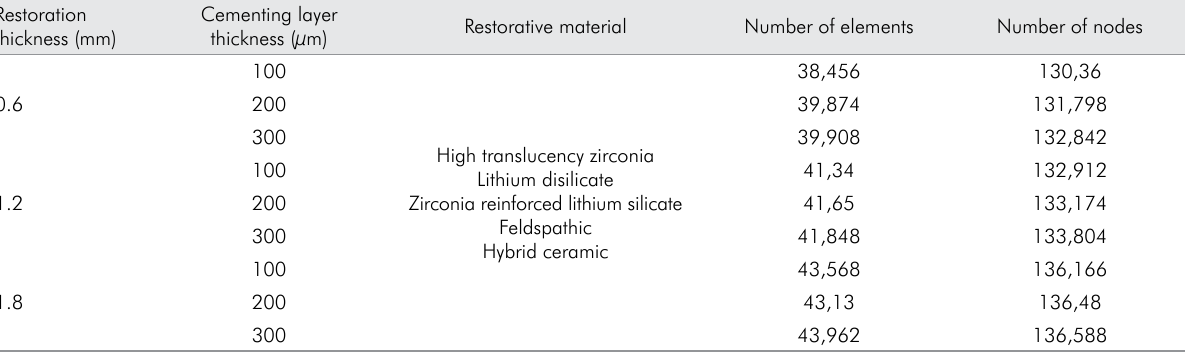
Table 1. Group distribution according to restoration thickness, cement layer thickness, and restorative material. Number of elements and nodes are shown for each 3D-FEA